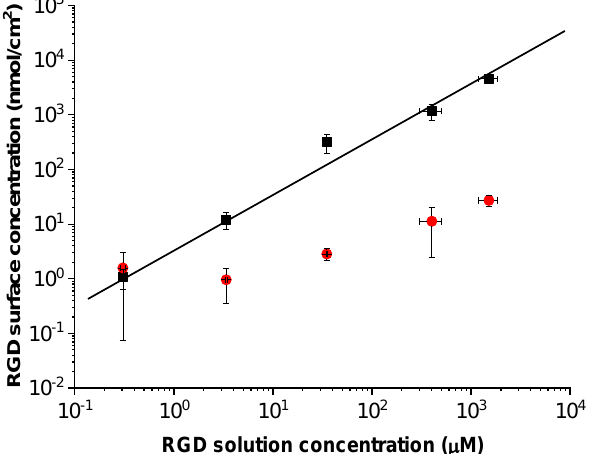
Figure 3. The surface concentration of RGD peptides ( ■ ) immobilized on poly(MeOEGMA- block -GMA-N 3 ) brushes (grown over Si substrates) linearly increases with increasing the peptide’s solution concentration. The surface concentration of physisorbed RGD peptides ( • ) was probed utilizing the same reaction conditions, but in absence of